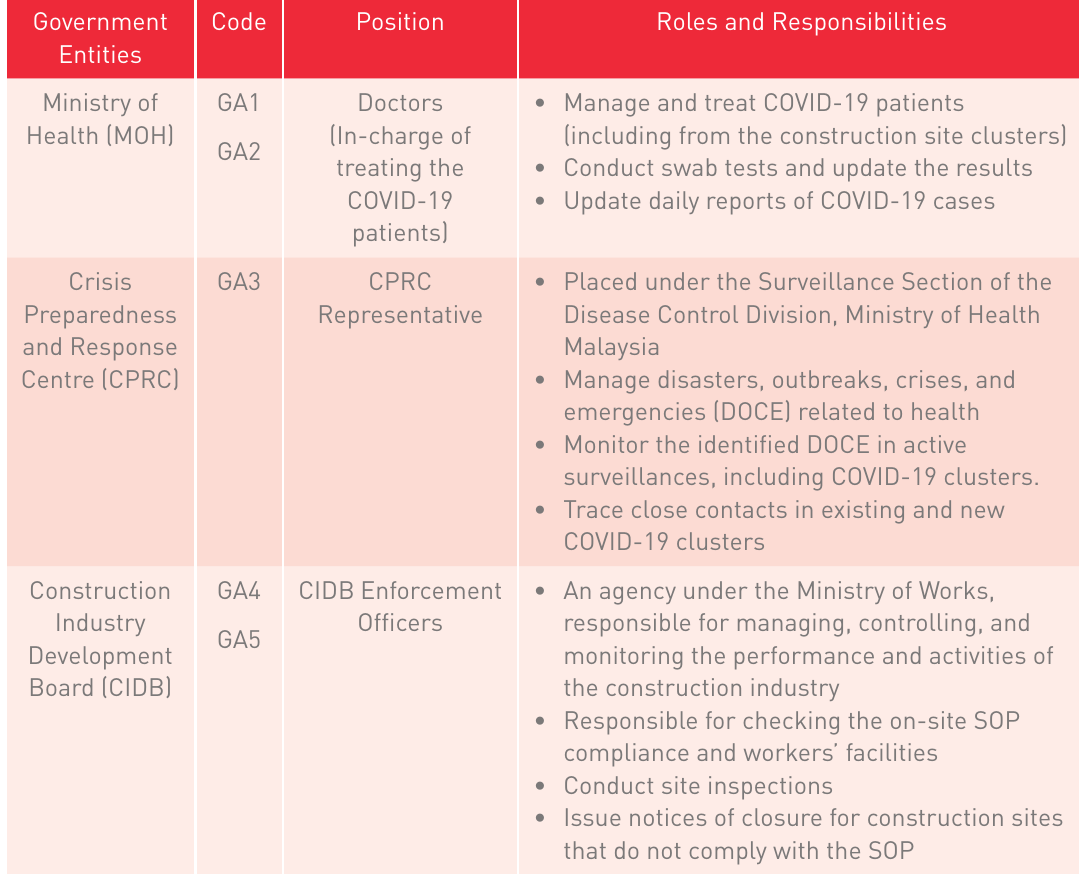
Profile of participants taking part in Phase One interviews (Government Entities) Roles and